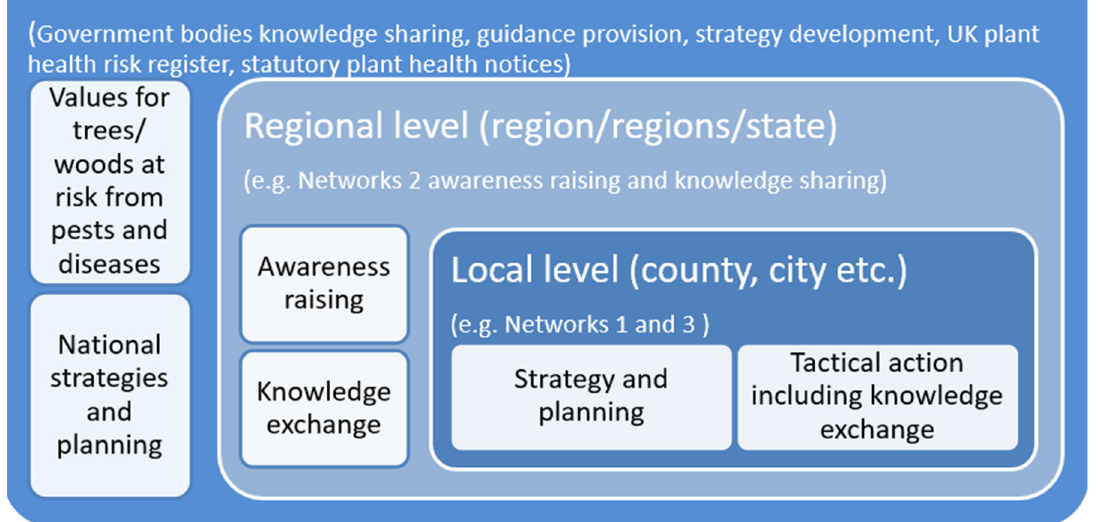
Figure 1. Mitigation and adaptation to tree pests and diseases on national, regional and local scales.